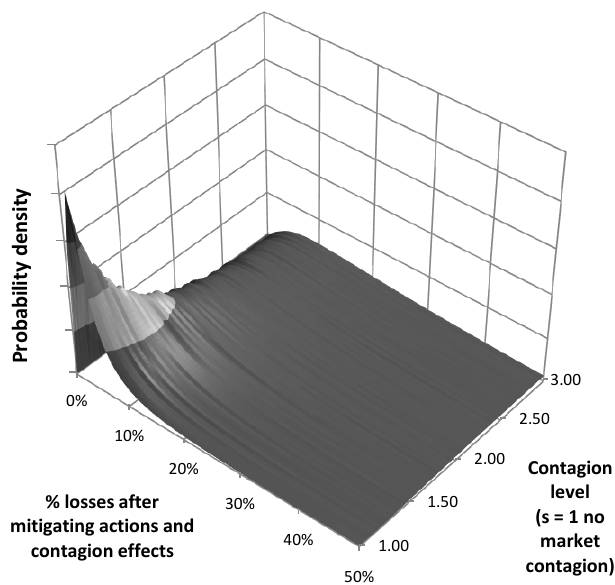
FIGURE 17: SA 2005, buffer restoration model output showing the dependence of loss probabilities on contagion level